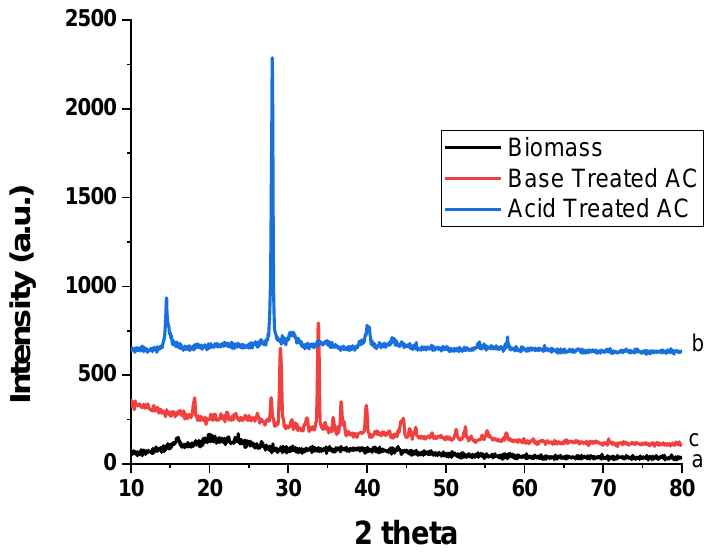
Figure 4. Powder XRD patterns of ( a ) biomass, ( b ) acid-treated AC and ( c ) base-treated AC.